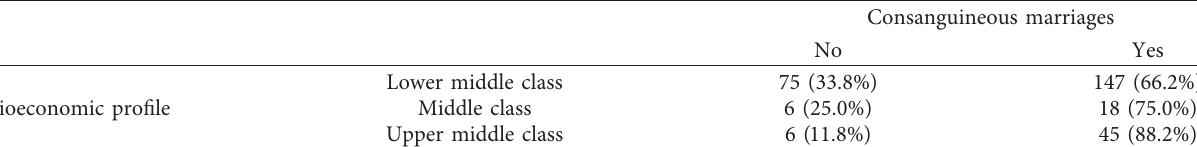
Table 2: Association of consanguineous marriages and socioeconomic status.